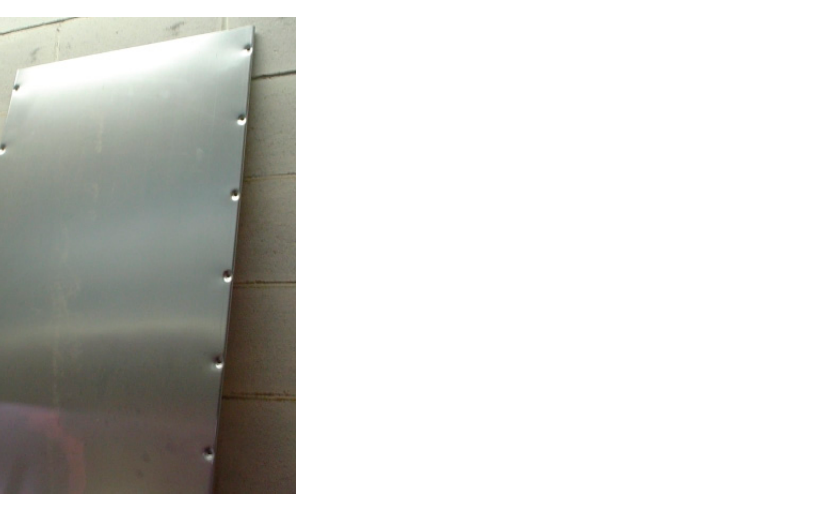
Figure 2. Sheet metal facia with plywood backing used in trailer inner liner wall panels.